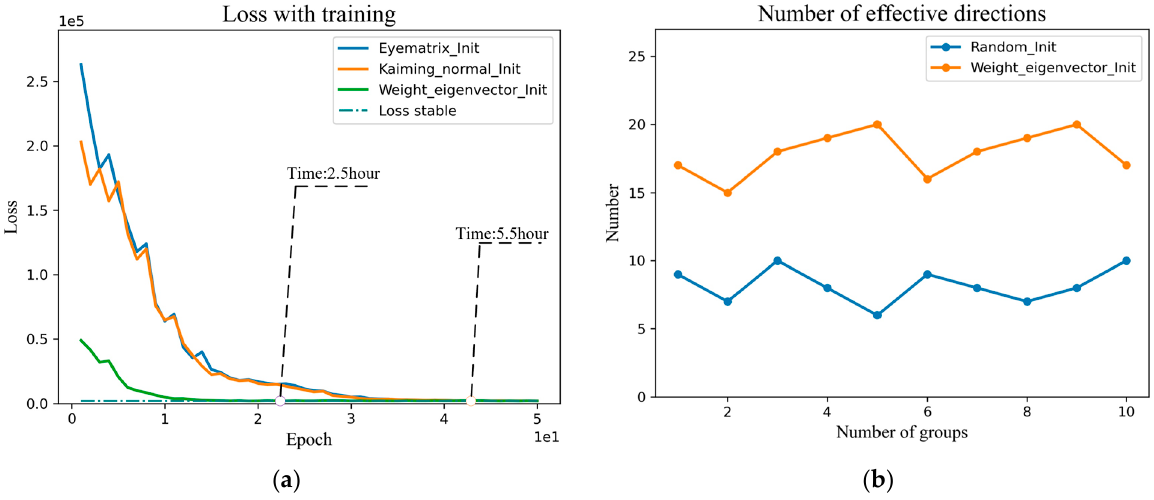
Figure 5. ( a ) Comparison of training time for loss convergence. ( b ) Comparison of the proportion of effective semantic editing directions.